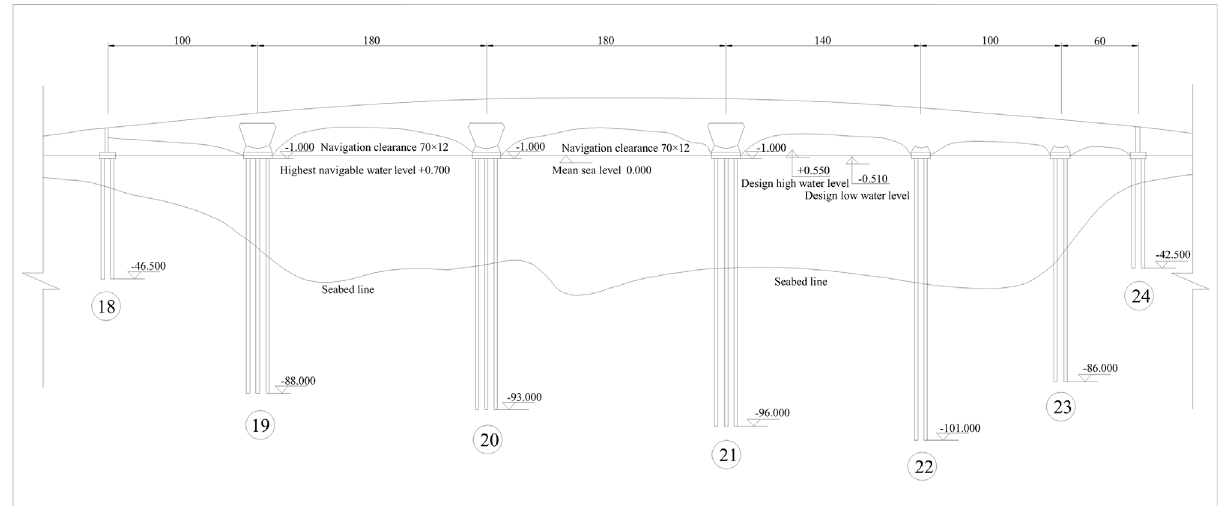
FIGURE 1 Layout of main bridge of malé — airport island bridge in